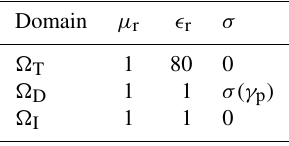
Table 1. Material properties assigned to the different domains for the computation of the optimized geometrical configurations.